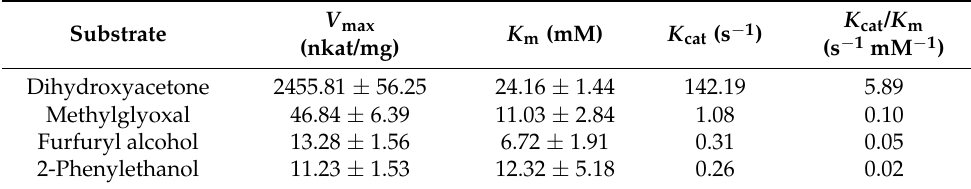
Table 2. Kinetic parameters of Tr LOx with different substrates. Standard deviations are presented as plus–minus